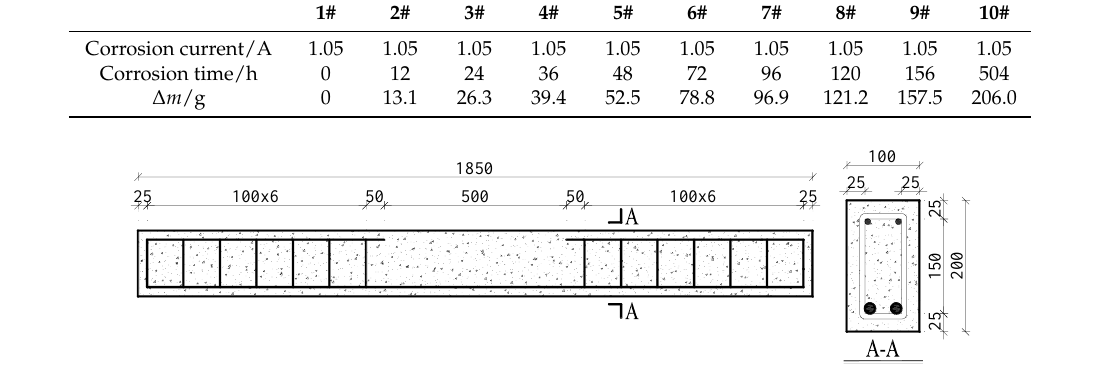
Figure 1. Dimensions of the tested beam (unit: mm).